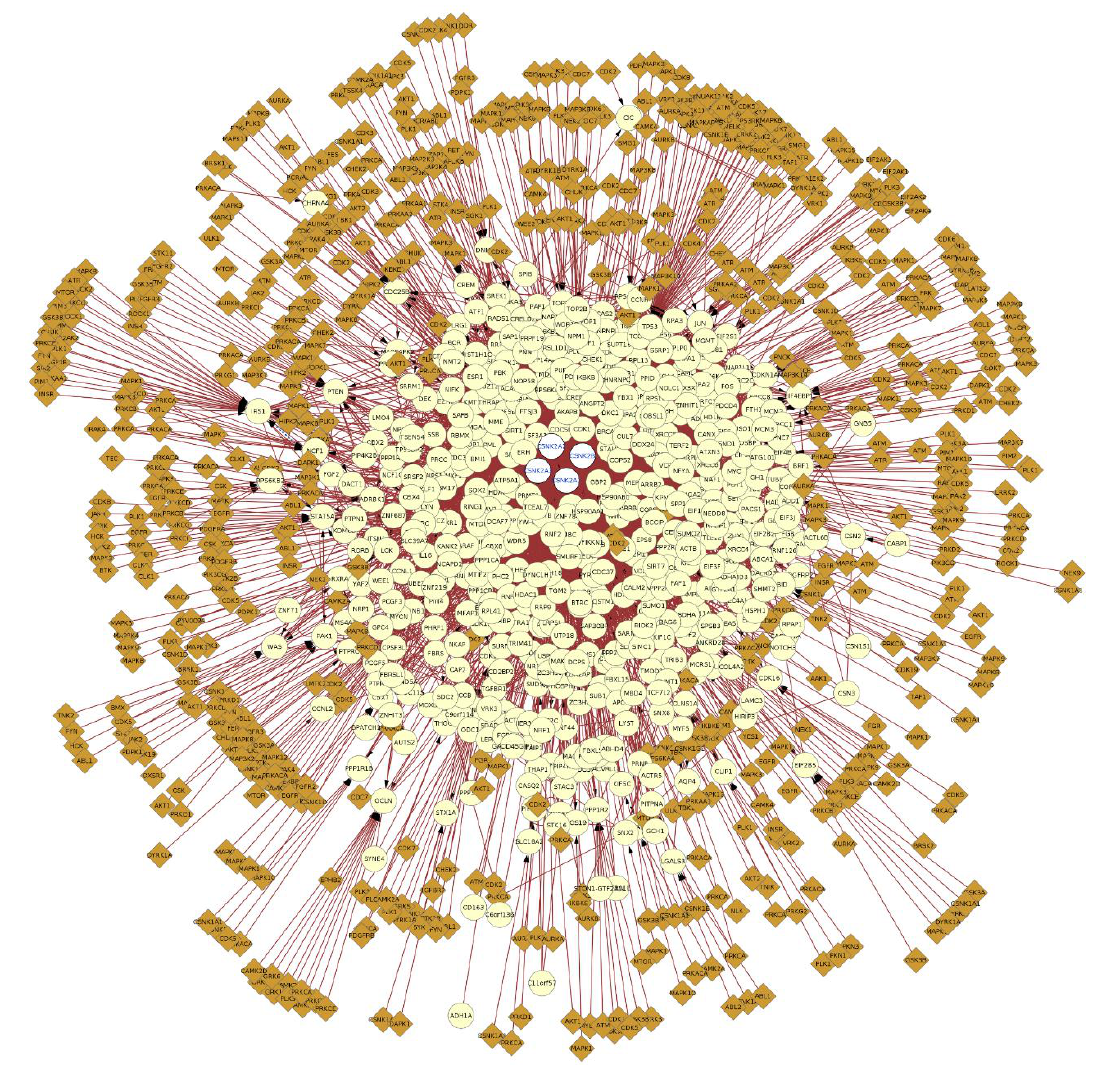
Figure 4. Protein–protein interaction network of CK2 subunits expanded to include kinase information of the interactors retrieved from PhosphositePlus, the network was represented with Cytoscape v3.4.0 using the BisoGenet v3.0.0 plugin and the PhosphositePlus Web Service Client Module. The yellow nodes represent CK2 interactors and the brown nodes represent kinases that phosphorylate (edges with arrow) the interactors. The blue edges represent protein–protein interactions and the red edges represent phosphorylation events. The network was represented as explained in Figure 2. Briefly, all the proteins were selected and the kinase data was added by importing the information from PhosphoSitePlus using the plugin and selecting the gene name as the matching key. A high resolution image of this figure is also available in the Supplementary Materials. Table 2. Post-translational modifications in the vicinity of CK2 1 target sites retrieved from PhosphoSitePlus (accessed August 2016).